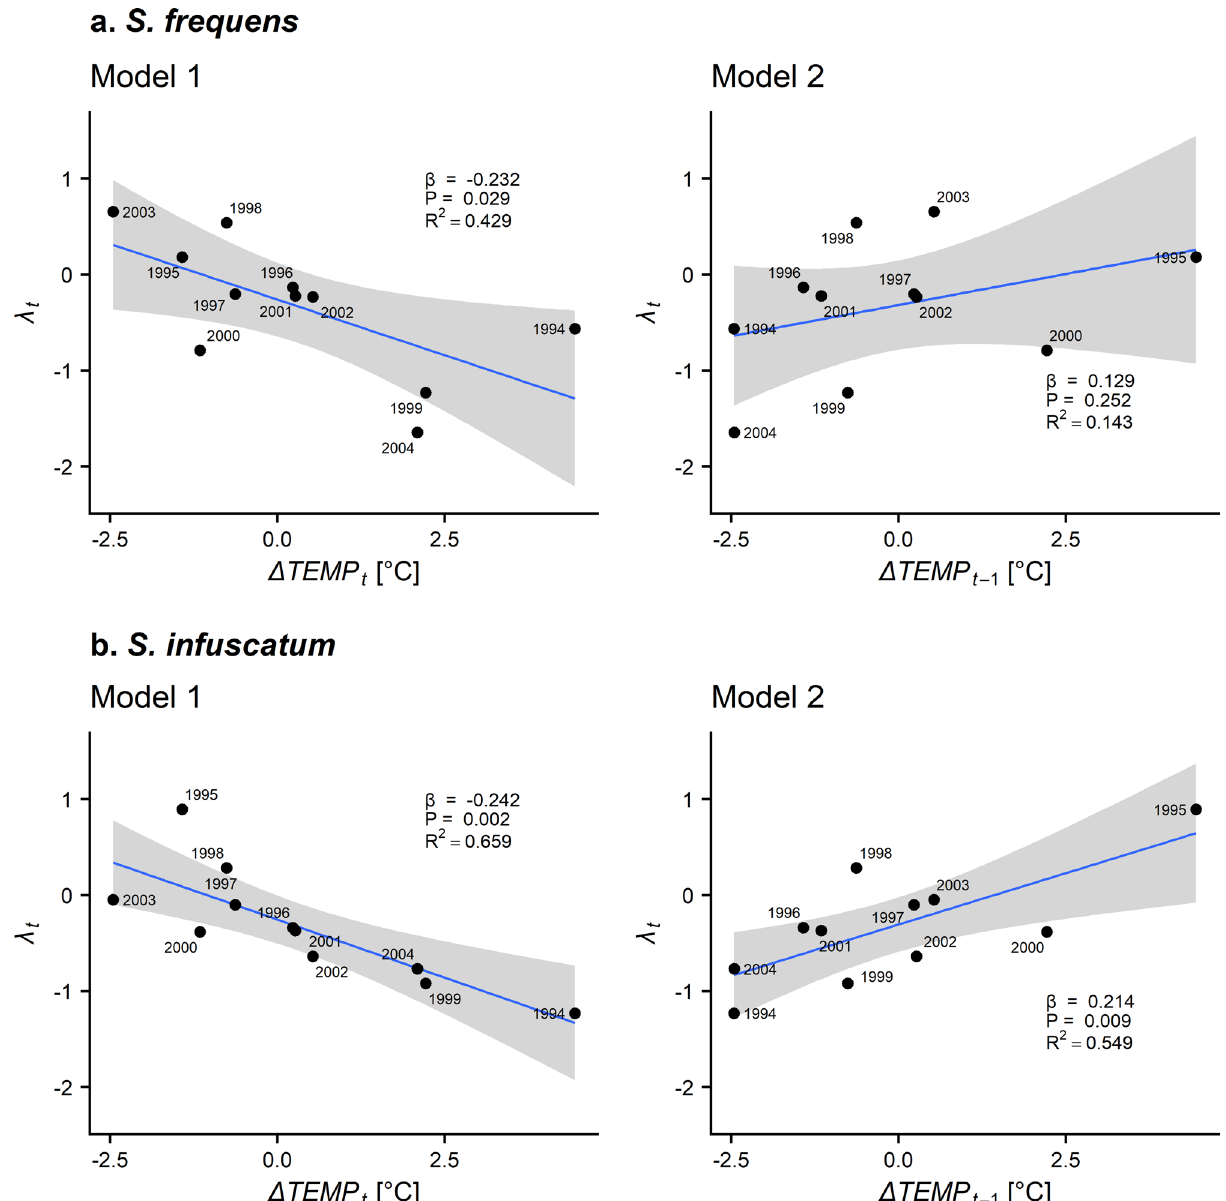
Figure 2. Association between Δ TEMP in the 90th percentile values of daily mean temperature during July– August (Δ TEMP t ) and population growth rate (λ t ) of ( a ) Sympetrum frequens and ( b ) S. infuscatum in Toyama Prefecture from 1993 to 2004. The shaded zone represents the 95% confidence interval. The labels indicate year t . The results of regression analyses are shown in each